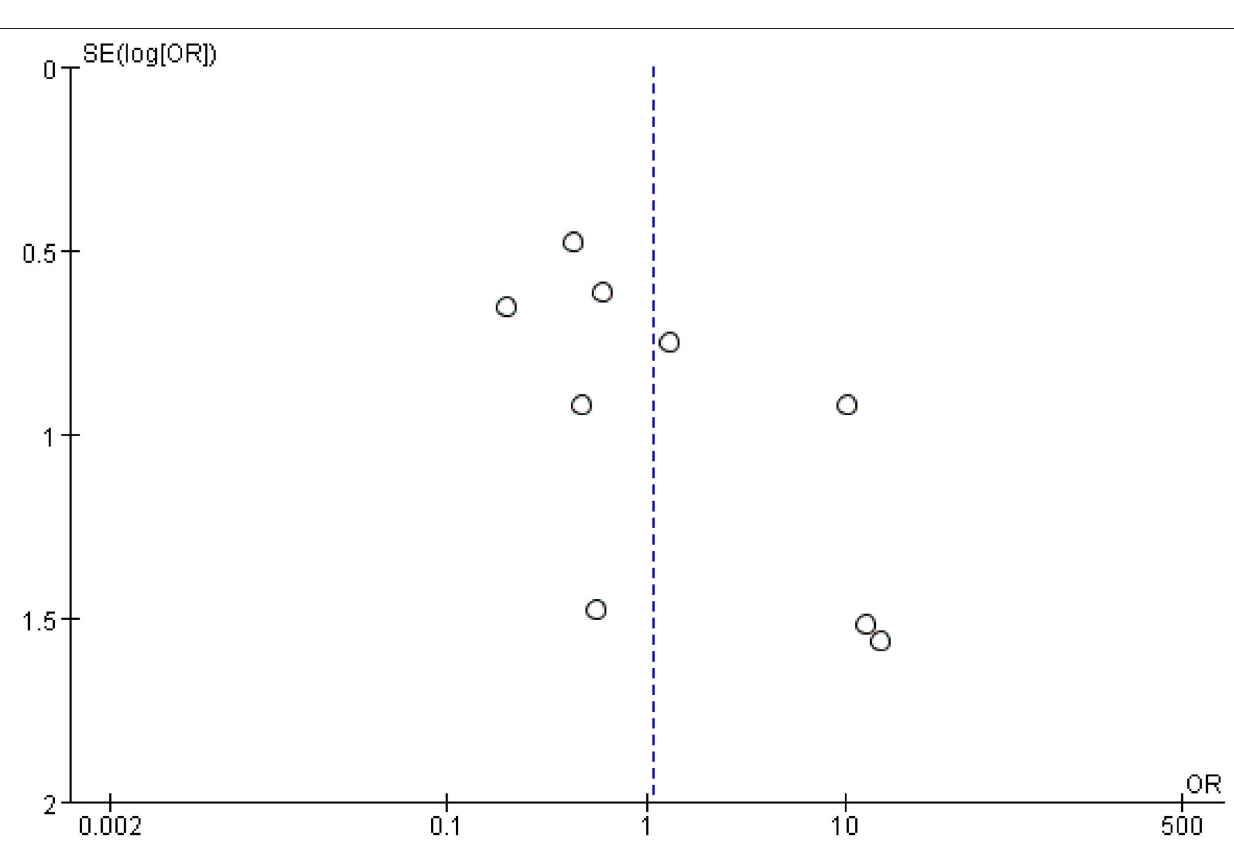
FIGURE 12 | Funnel plot of late adverse events between EUS-CDS and